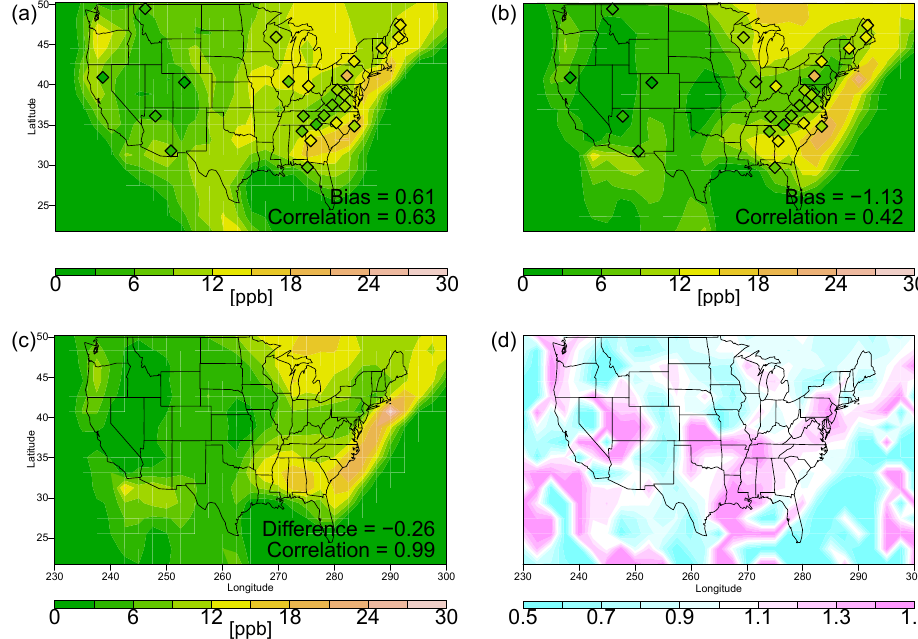
Figure 7. Rescaled data. Average MDA8 ozone (ppb) conditioned on daily maximum temperature greater than the 90th percentile minus av- erage MDA8 ozone for (a) the CESM1 REFC1SD simulation (1992–2010), (b) the GCM2000 simulation (2006–2025) and (c) the GCM2100 simulation (2106–2125). The biases, differences and correlations are defined similarly to in Fig. 2. (d) (cid:57)( O 3 ,T ) (See the definition of (cid:57) in Eq.